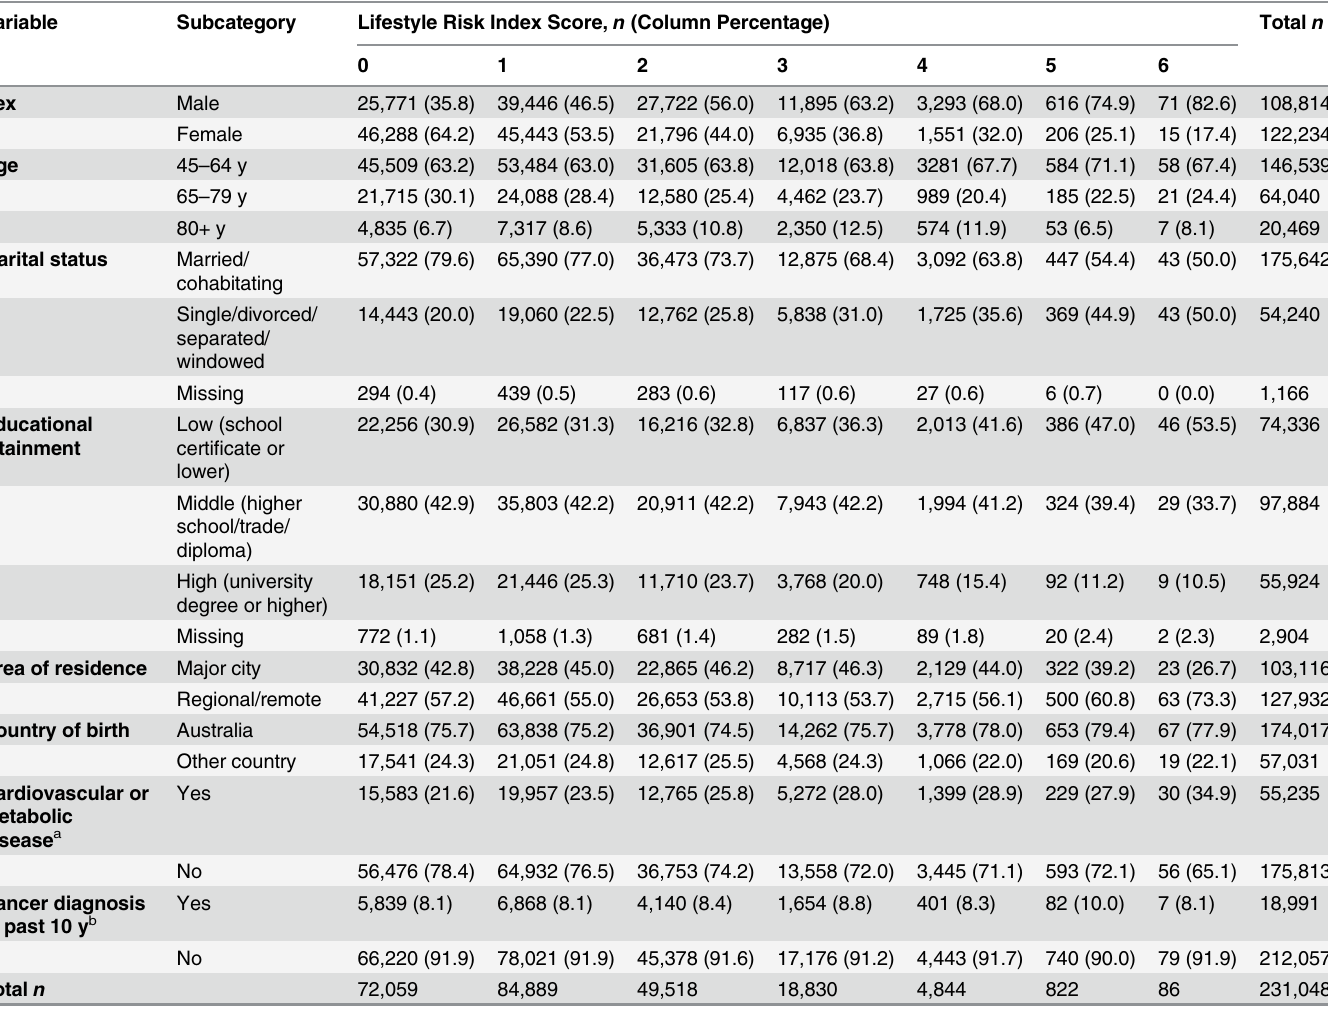
Table 2. Socio-demographic and health characteristics of adults by lifestyle risk index score in New South Wales, Australia (2006 – 2009, n = 231,048).